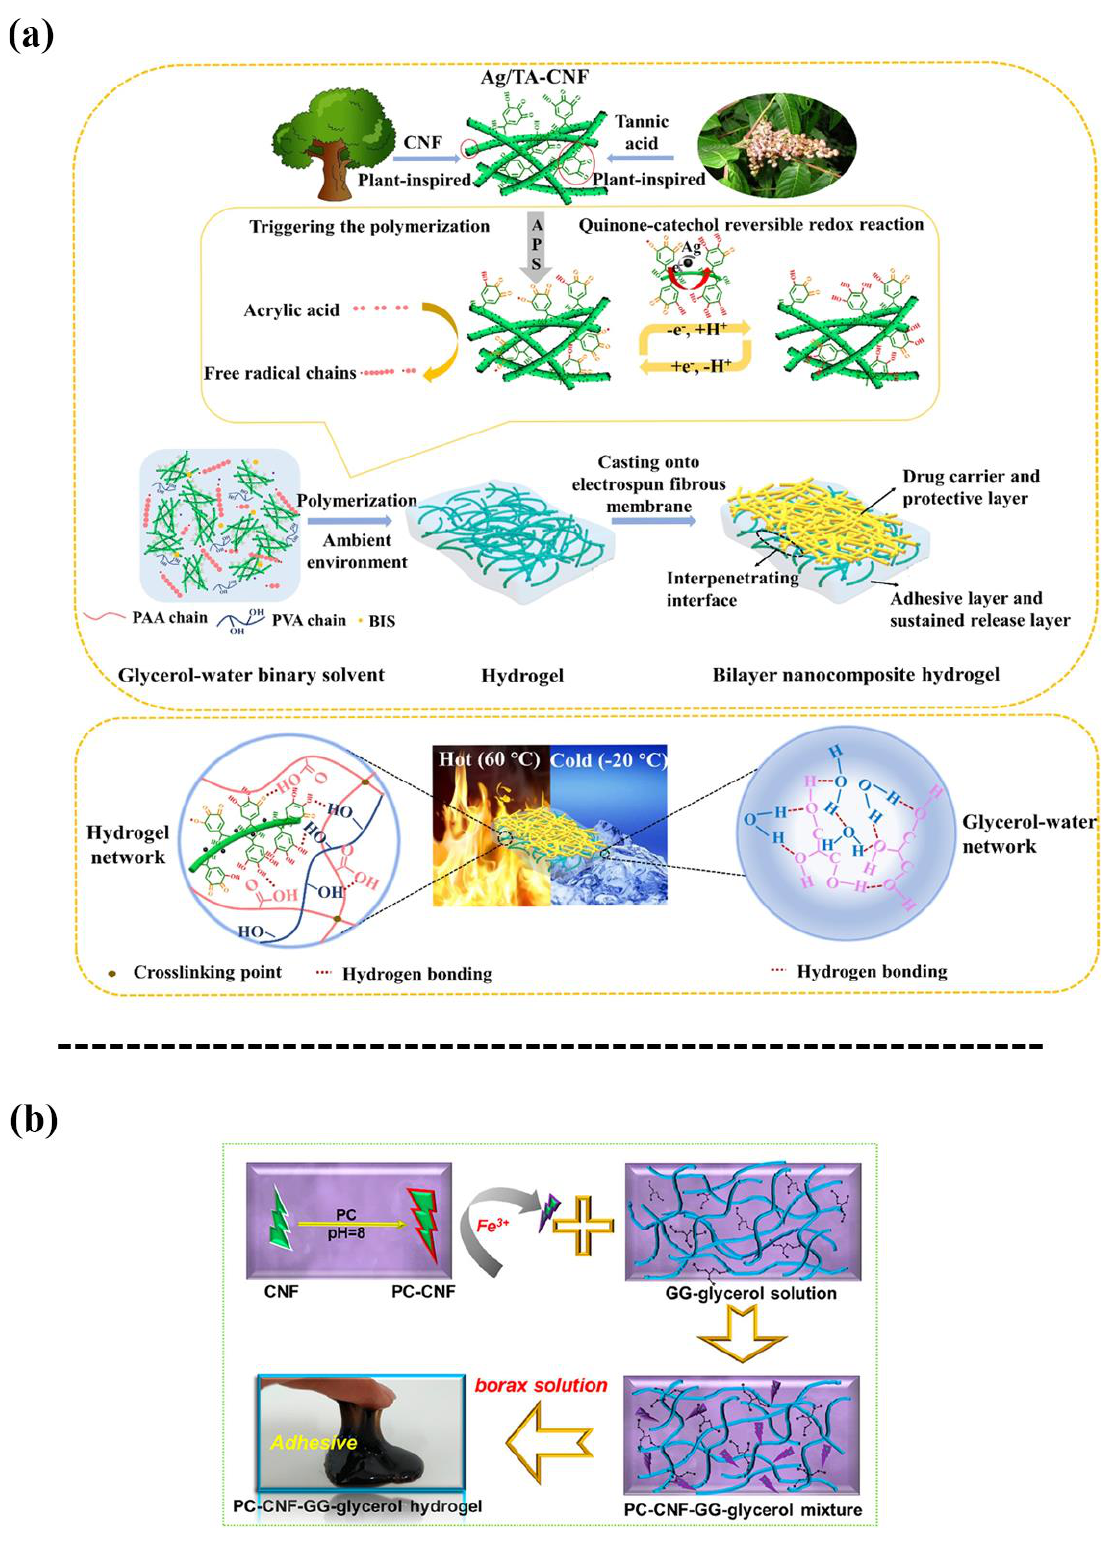
Figure 13. ( a ) Design strategy of a multifunctional hydrogel by co-polymerizing acrylic acid (AA), polyvinyl alcohol (PVA), and silver /TA-CNF in a glycerol-water binary solvent [81]. ( b ) Preparation of a PC-CNF-GG-glycerol hydrogel [82].